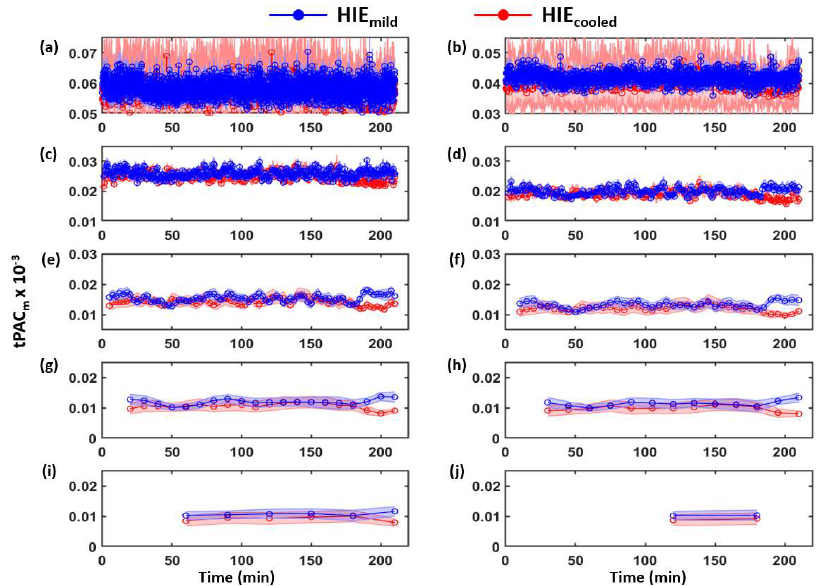
Figure A2. tPAC m indexes at C3 from HIE mild (blue) and HIE cooled (red) under ( a ) 10 s; ( b ) 20 s; ( c ) 1 min; ( d ) 2 min; ( e ) 5 min; ( f ) 10 min; ( g ) 20 min; ( h ) 30 min; ( i ) 60 min; ( j ) 120 min window sizes. Each point denotes the cross-neonate average of tPAC m for the group at different time in the 6 HOL. The shaded error bar indicates the standard error of the mean. t = 0 indicates the start of EEG recording. HOL: hours of life.